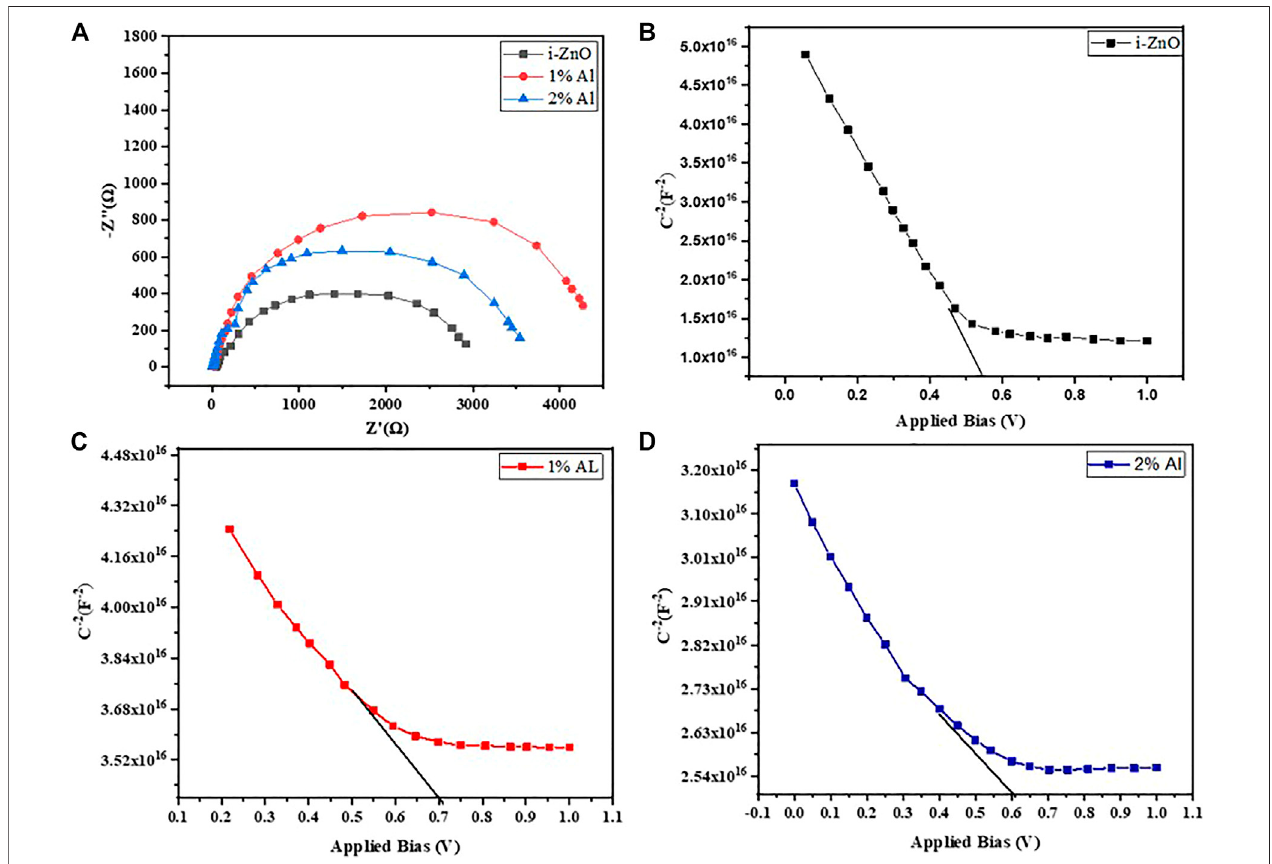
TABLE 3 | Electrical properties of